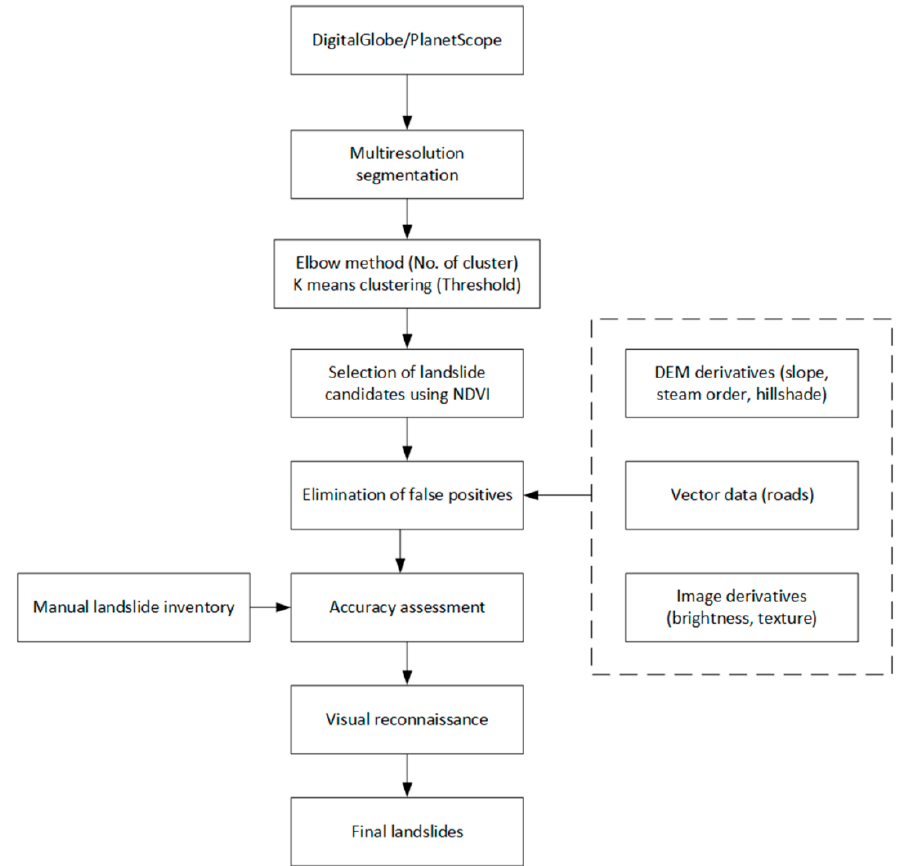
Figure 4. Workflow chart showing each step taken in object-based image analysis (OBIA) landslide